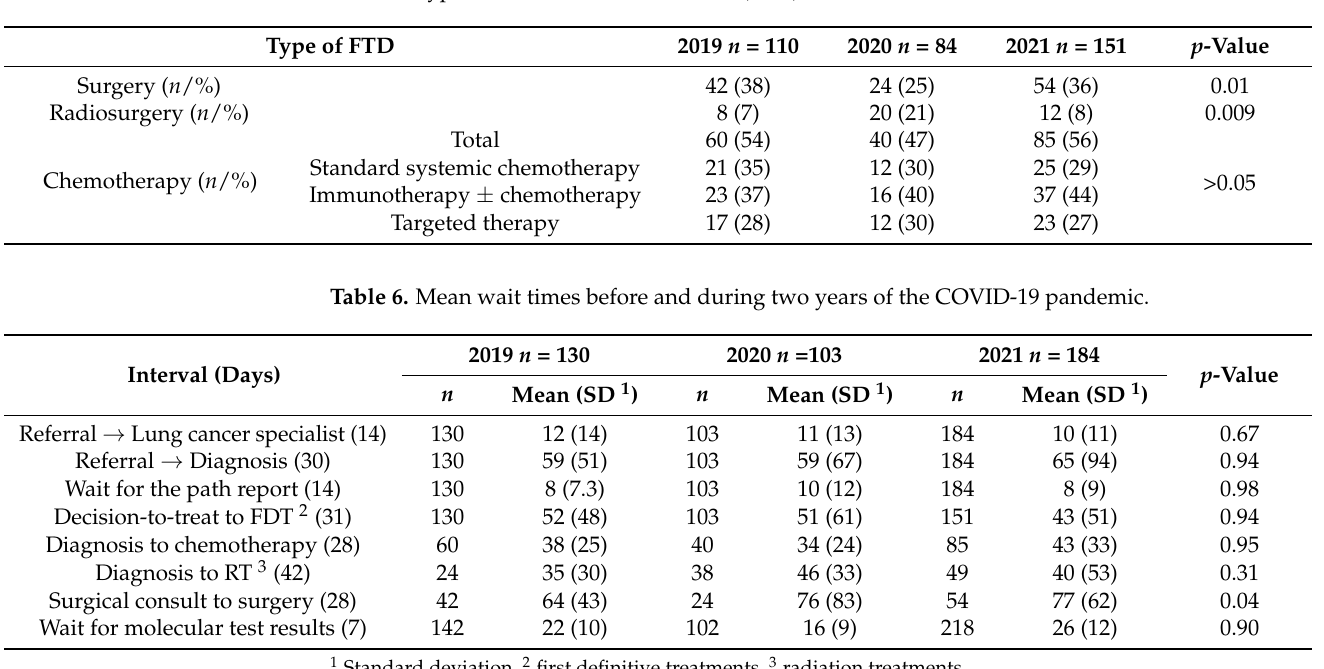
Table 5. Type of first definitive treatment (FTD).